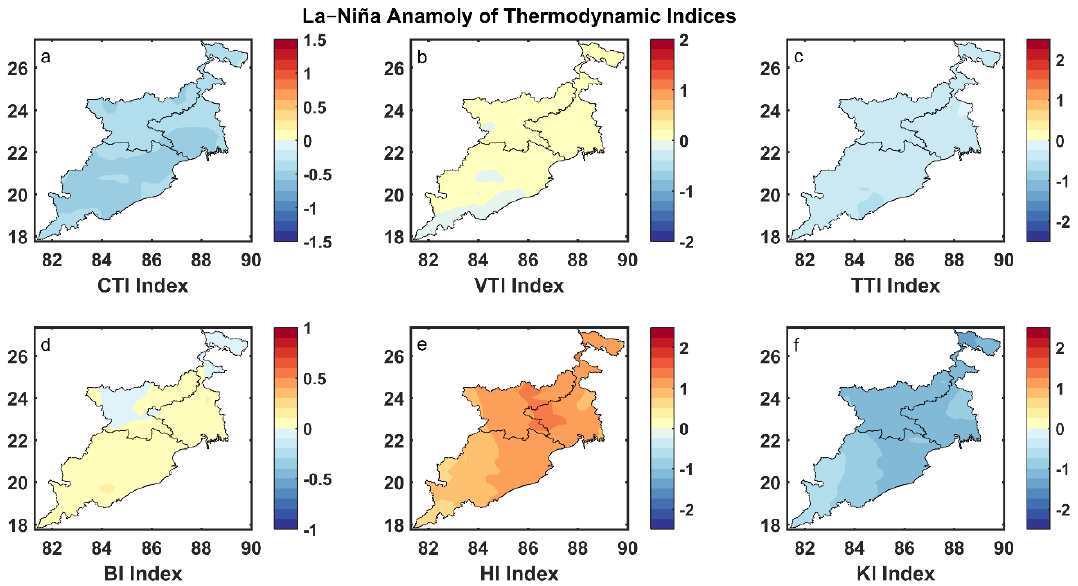
Figure 10. CTI ( a ), VTI ( b ), TTI ( c ), BI ( d ), HI ( e ), KI ( f ) anomalies during La-Niña years from 1987 to 2019.